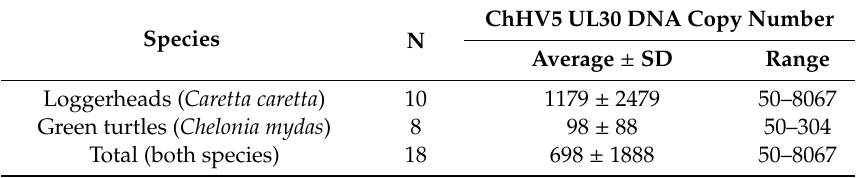
Table 5. Summarized quantitative data on the copy number (per µ g DNA) for 18 rehabilitating sea turtles that tested positive for chelonid alphaherpesvirus 5 (ChHV5) UL30 DNA via quantitative polymerase chain reaction (qPCR) and sequencing. SD, standard